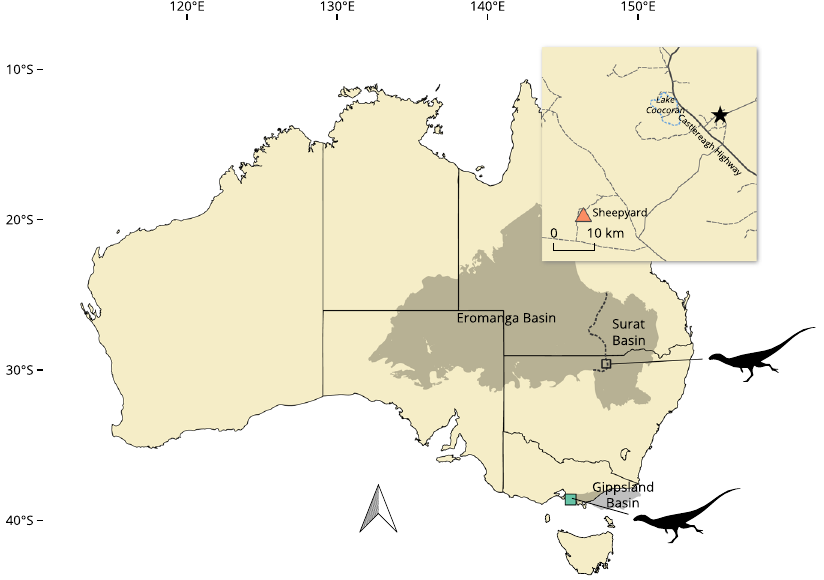
Figure 1. Map of Australia showing the location of Lightning Ridge and the Sheepyard opal field in central north New South Wales (inset) and San Remo in southern Victoria. The Eromanga, Surat and Gippsland basins are represented by the grey areas; the dashed line indicates the boundary between the Eromanga and Surat basins. The inset map, indicated by the square on the main map, shows location of the Sheepyard opal field (orange triangle) where LRF 3050.AR was found in the vicinity of Lightning Ridge (black star). The location of San Remo on the south coast of Victoria, the area in which NMV P221202 was discovered, is indicated by the green square. Australia coastline uses data taken from GEODATA COAST 100 K 2004 provided by Geoscience Australia (http://www.ga.gov.au/metadata-gateway/metadata/record/61395). Basin extents data from Australian Geological Provinces, 2013.01 edition (http://www.ga.gov.au/metadata-gateway/metadata/ record/74371/); both released by Geoscience Australia under CC BY 4.0 license (https://creativecommons. org/licenses/by/4.0/). Silhouette by Tasman Dixon and released under a Public Domain Dedication 1.0 license (http://creativecommons.org/publicdomain/zero/1.0/). Roads and geographic map data © OpenStreetMap contributors (https://www.openstreetmap.org); data made available under the Open Database License (https://